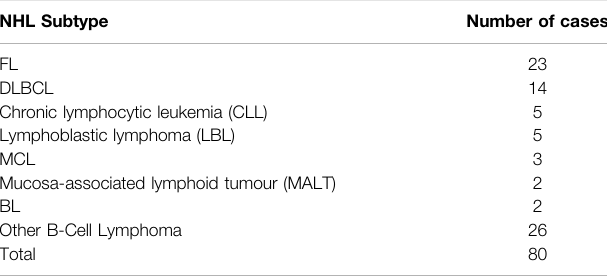
TABLE 1 | GLP NHL case cohort with subtypes and number of cases for each subtype listed. NHL Subtype